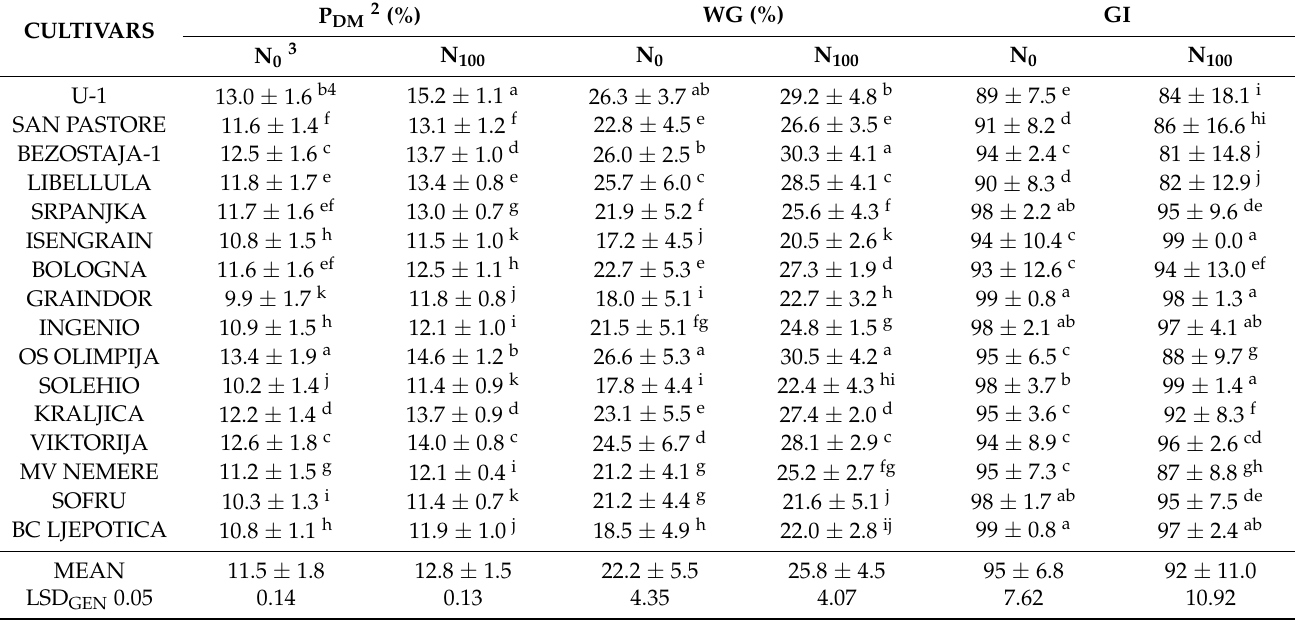
Table 2. Mean 1 values of grain and flour quality in wheat under low and high N levels.